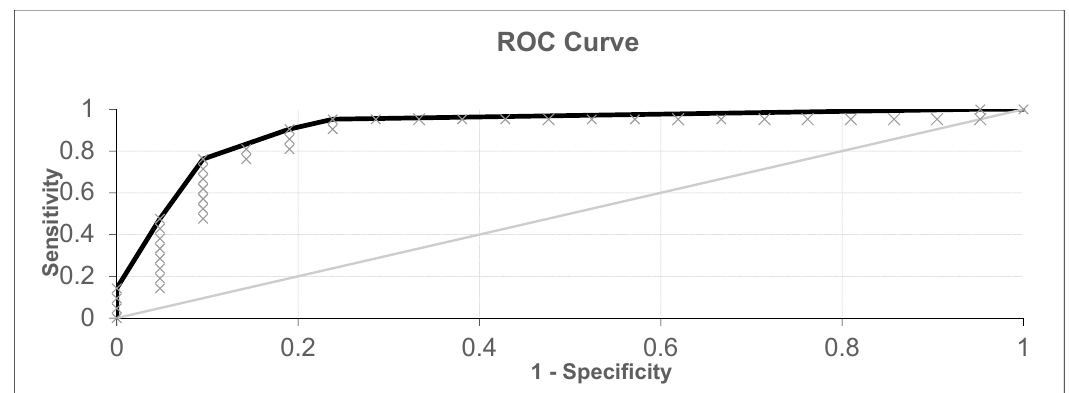
Figure 5. ROC curve for healthy patients and lung cancer patients (black curve – ROC curve, grey line – Reference line and grey x – experimental points).